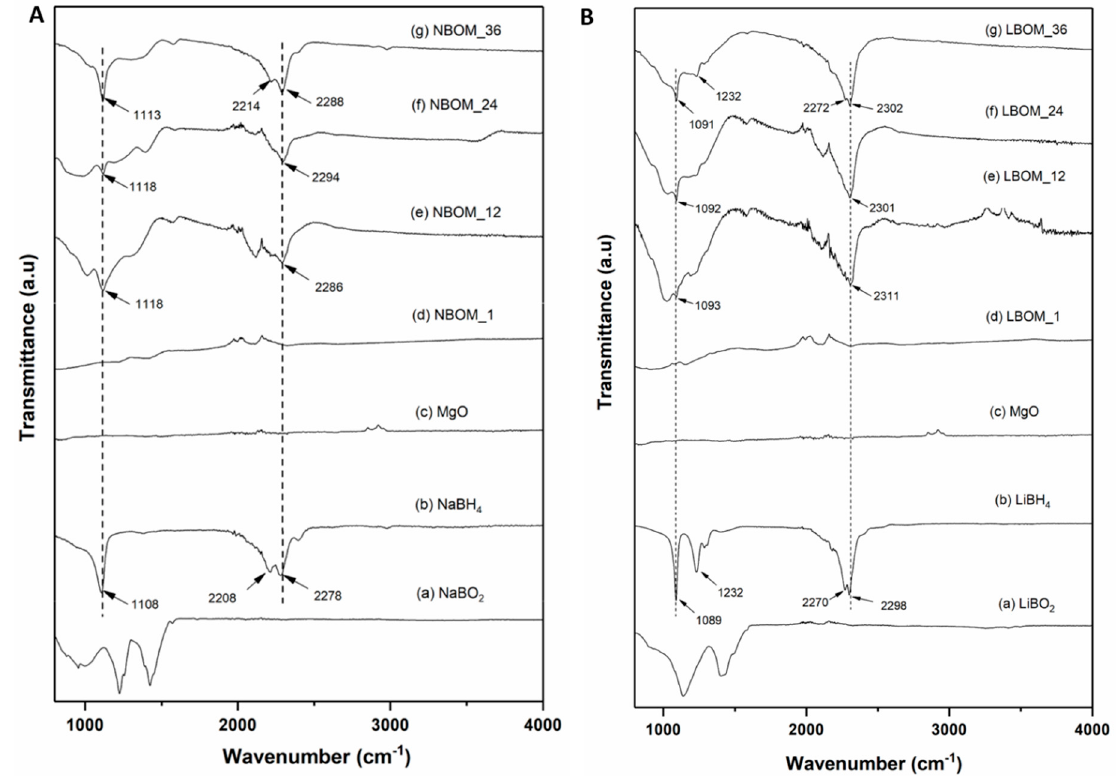
Figure 4. FT-IR spectra of materials: ( A ) (a) NaBO 2 .; (b) NaBH 4 ; (c) MgO; (d) NBOM_1; (e) NBOM_12; (f) NBOM_24; and (g) NBOM_36; ( B ) (a) LiBO 2 ; (b) LiBH 4 ; (c) MgO; (d) LBOM_1; (e) LBOM_12; (f) LBOM_24; and (g) LBOM_36. Table 3. Infrared vibration bands of NaBH 4 , NaBO 2 , and ball-milled materials at different milling time durations at room temperature.